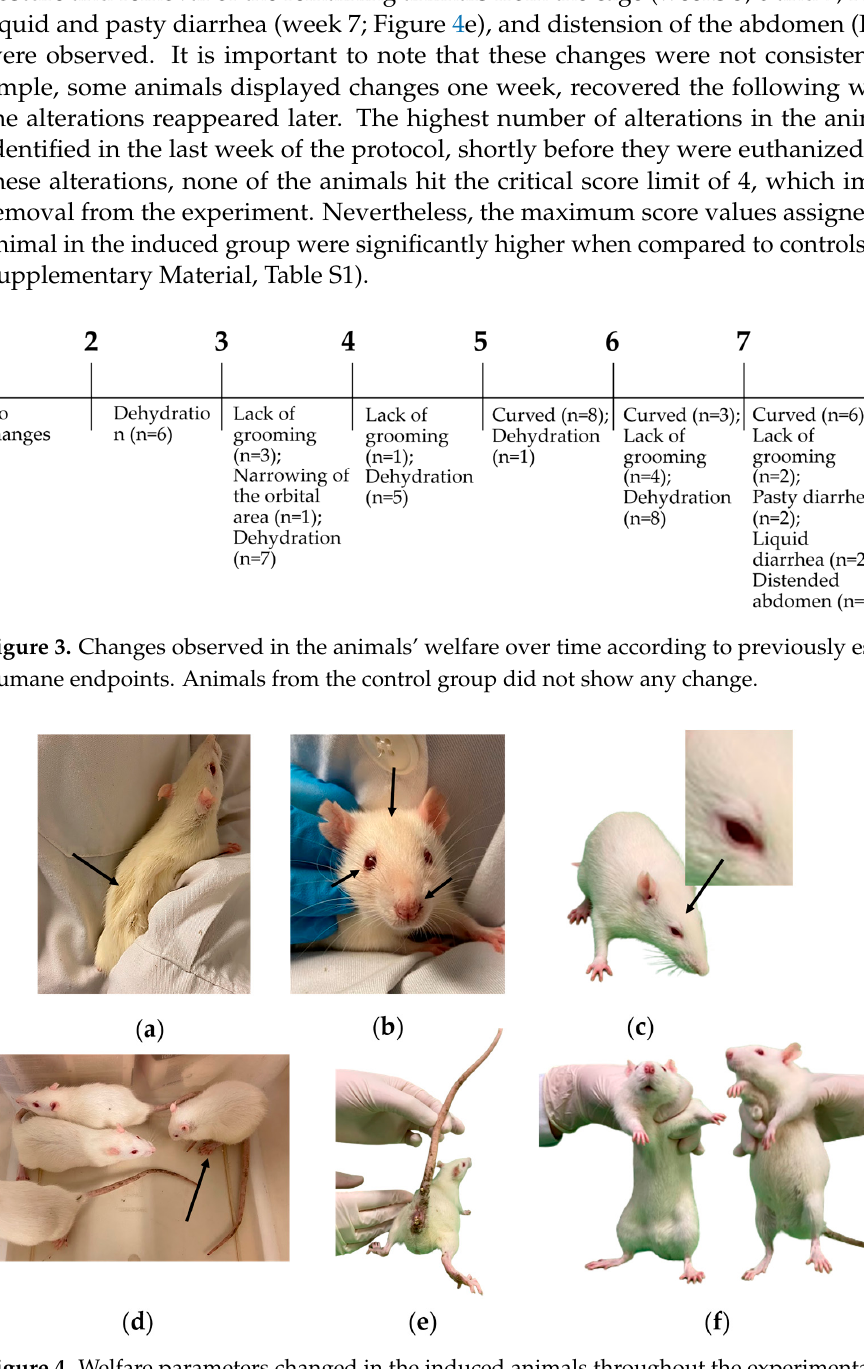
9 of 18 Figure 2. ( a ) Mean body weight of each group, ( b ) mean body weight gain, ( c ) mean food and ( d ) water consumption per day throughout the trial in both experimental groups. * Statistically di ff erent